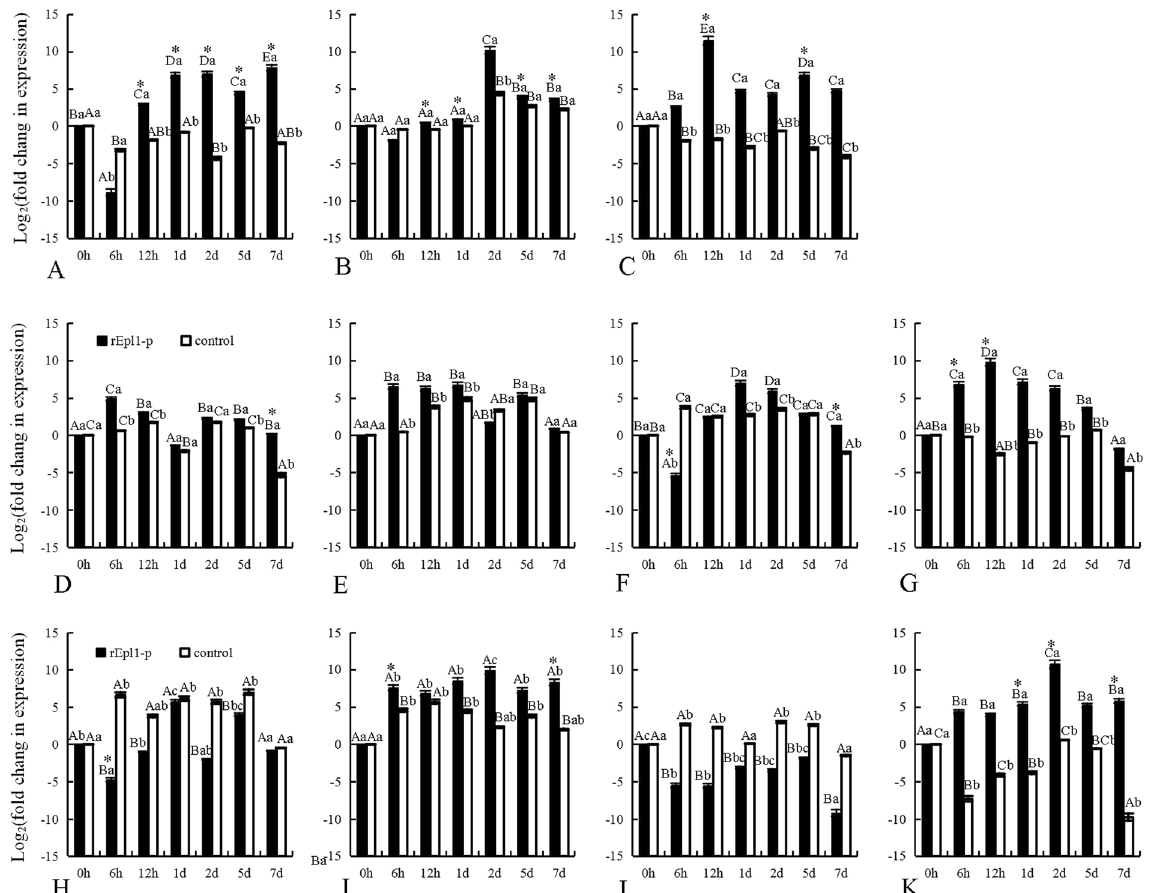
Figure 7. Transcription of 11 genes related to hormone signaling in Populus davidiana × P . alba var. pyramidalis (PdPap) seedlings under rEpl1-p induction. X-axis: time points, Y-axis: expression level = Log 2 (fold change in expression). ( A – C ) The expression levels of NPR1 , TGA , and PR1 in the SA signal transduction pathway; ( D–G ) The expression levels of COI , JAZ6 , MYC2 , and ORCA3 in the JA signal transduction pathway; ( H – K ) The expression levels of TIR1 , IAA8 , MP/ARF , and GH3 in the auxin signal transduction pathway. Different capital letters represent significant differences among different time points of treatment or the control group; different lowercase letter represent significant differences between the treatment and the control at the same time point; * significant difference between rEpl1-e and rEpl1-p treatments at the same time point. All significances were at p < 0.5. All experiments were performed three times. The quantitative data are presented in Supplementary Table